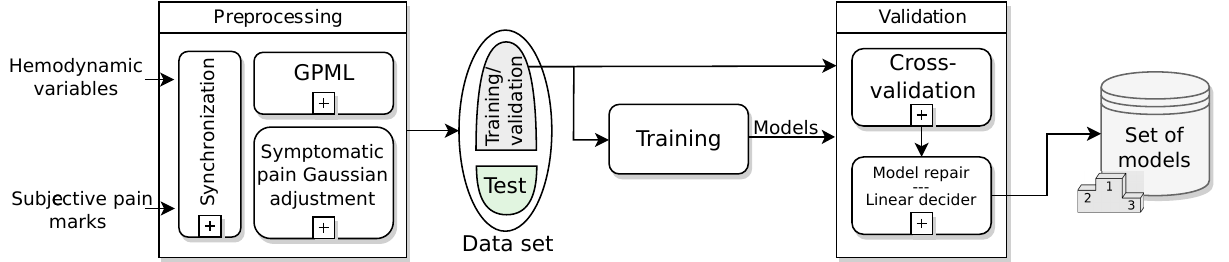
Figure 3. Training and validation diagram. This stage provides a set of models with which to